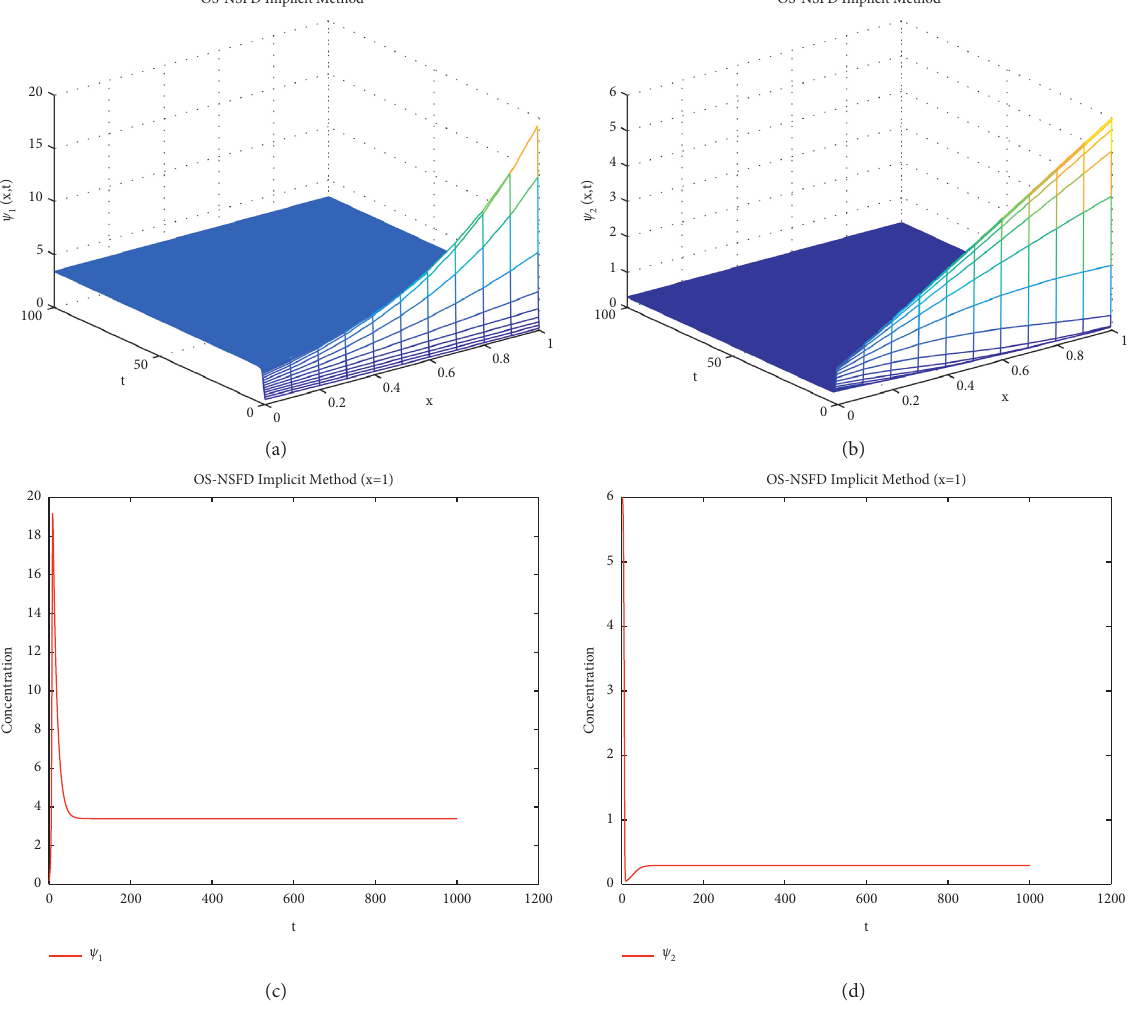
Figure 8: Mesh and plot graphs of ψ � 1 , ϑ � 3 . 4 , λ � λ � 0 . 001 , and ε κ � 0 . 1 , ϑ 1 2 1 2 (d) Plot graph of ψ 2